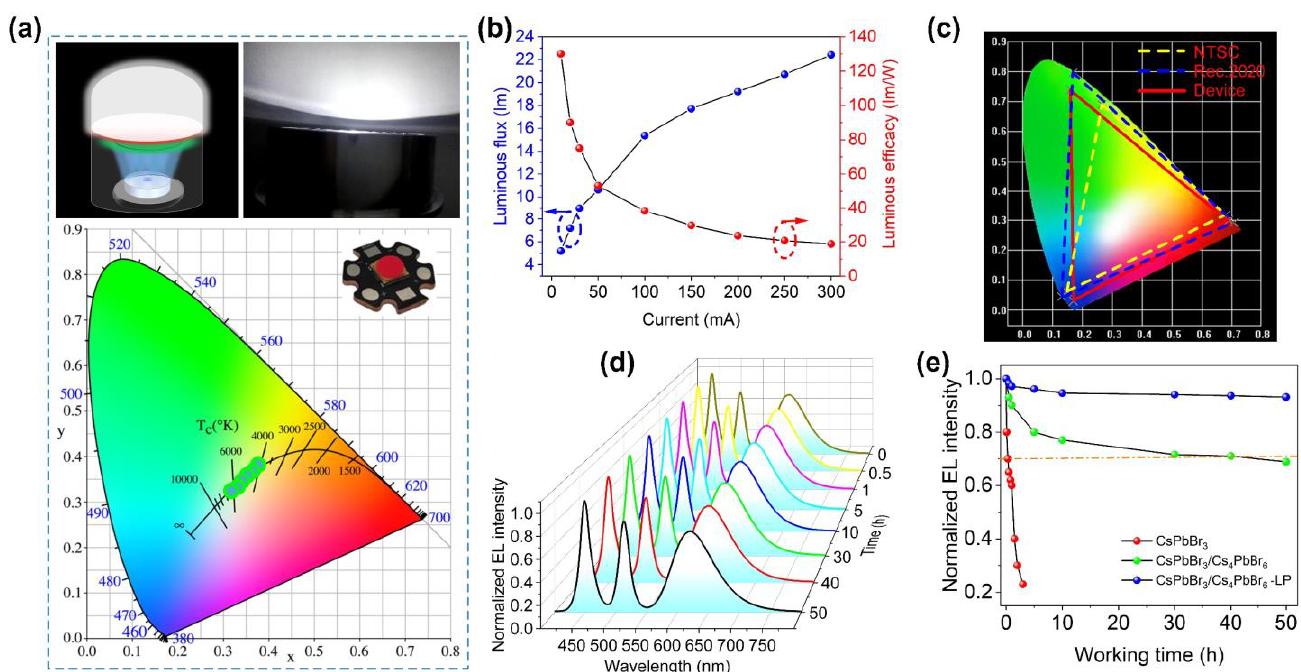
Figure 8. ( a ) A schematic and physical diagram of CsPbBr 3 /Cs 4 PbBr 6 –LP WLED devices and their corresponding color coordinates in a CIE diagram at different forward-bias currents (10–300 mA). ( b ) The changes in luminous efficiency and luminous flux of the CsPbBr 3 /Cs 4 PbBr 6 –LP WLEDs at different forward-bias currents. ( c ) Color coordinates and color gamut of CsPbBr 3 /Cs 4 PbBr 6 –LP WLEDs plotted on the CIE1931 chromaticity diagram. CsPbBr 3 /Cs 4 PbBr 6 –LP WLED device (red line), NTSC standard (yellow dashed line), and Rec. 2020 standard (blue dashed line). ( d ) The electroluminescence (EL) spectra of the WLEDs were measured at different working times (0–50 h). ( e ) Comparison of the normalized green light EL intensity of the WLED devices using pure CsPbBr 3 QD powders, CsPbBr 3 /Cs 4 PbBr 6 microcrystals, and CsPbBr 3 /Cs 4 PbBr 6 – LP microcrystals at different working times.